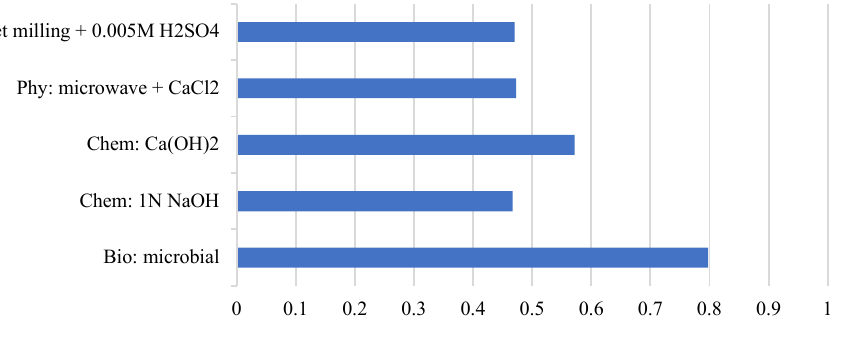
Fig. 2. Multi-criteria analysis